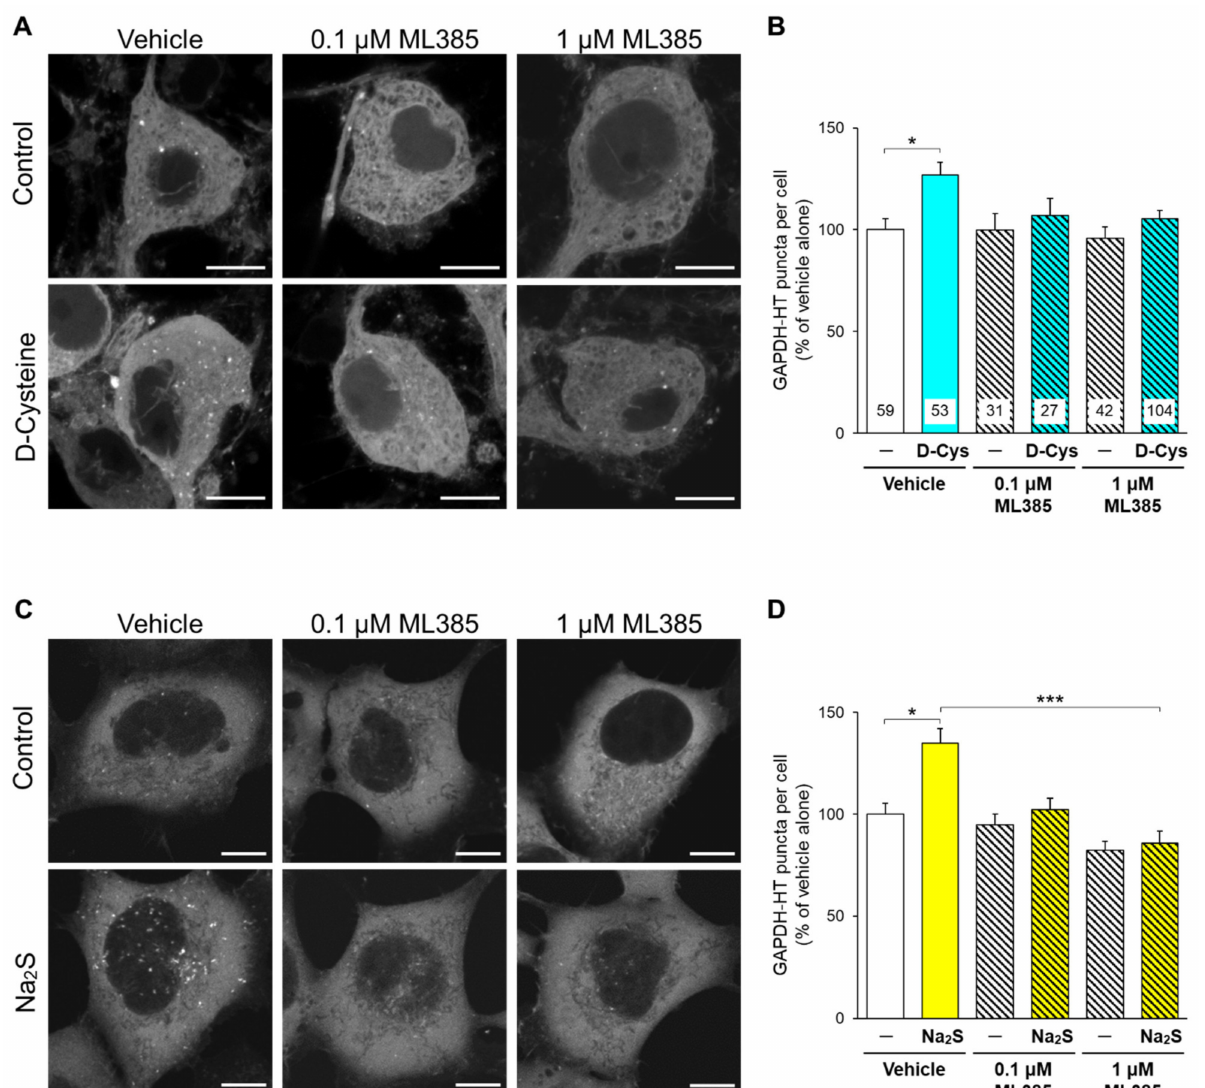
Figure 5. Effect of an Nrf2 inhibitor on the D-cysteine- and Na 2 S-induced activation of CMA in primary cultured PCs and AD293 cells. ( A ) Punctate accumulation of GAPDH-HT in primary cultured PCs treated with D-cysteine (1 mM) in the presence of a vehicle (0.1% dimethyl sulfoxide) or ML385 (0.1 and 1 µ M) for 24 h. ( B ) Quantitative analyses of GAPDH-HT puncta shown in A. ( C ) Punctate accumulation of GAPDH-HT in AD293 cells treated with Na 2 S (10 µ M) in the presence of the vehicle or ML385 for 24 h. ( D ) Quantitative analyses of GAPDH-HT puncta shown in C. Scale bars = 10 µ m. Numbers in the columns represent the numbers of observed cells. * p < 0.05, *** p < 0.001 (Dunn’s multiple comparisons